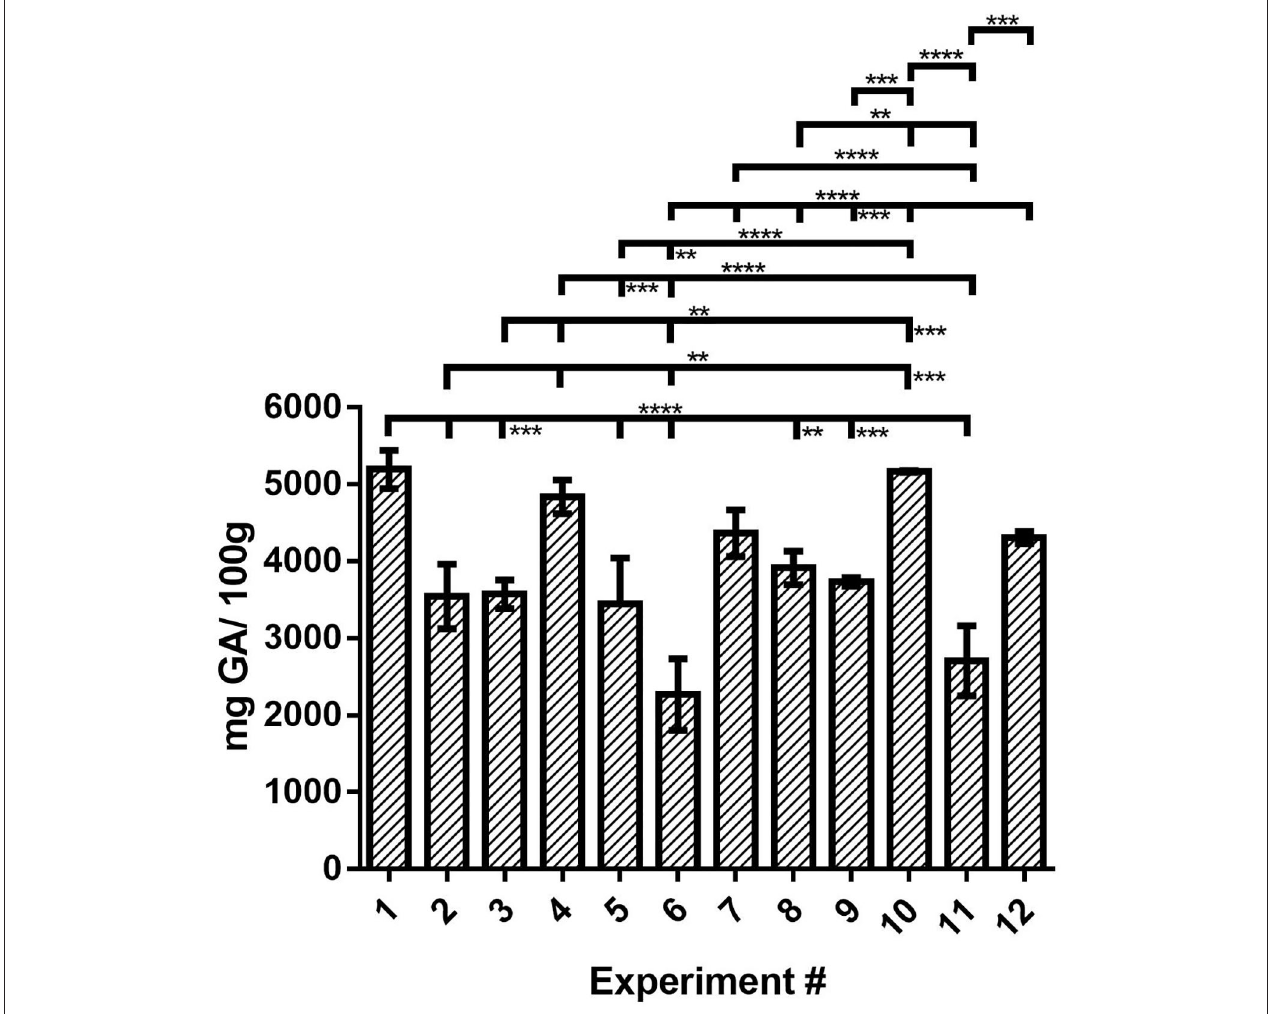
FIGURE 1 | TPC of the OLEU-EE determined by Folin–Ciocalteu assay and comparison of mean ± SD values by one-way ANOVA with Tukey’s test of the TPC for the 12 experiments. With a confidence interval of 95% ( α = 0.05), significance is represented by brackets with two asterisks (**) identify adjusted P-values between 0.01 and 0.001, three asterisks (***) identify adjusted P-values between 0.001 and 0.0001, and four asterisks (****) identify adjusted P -values <